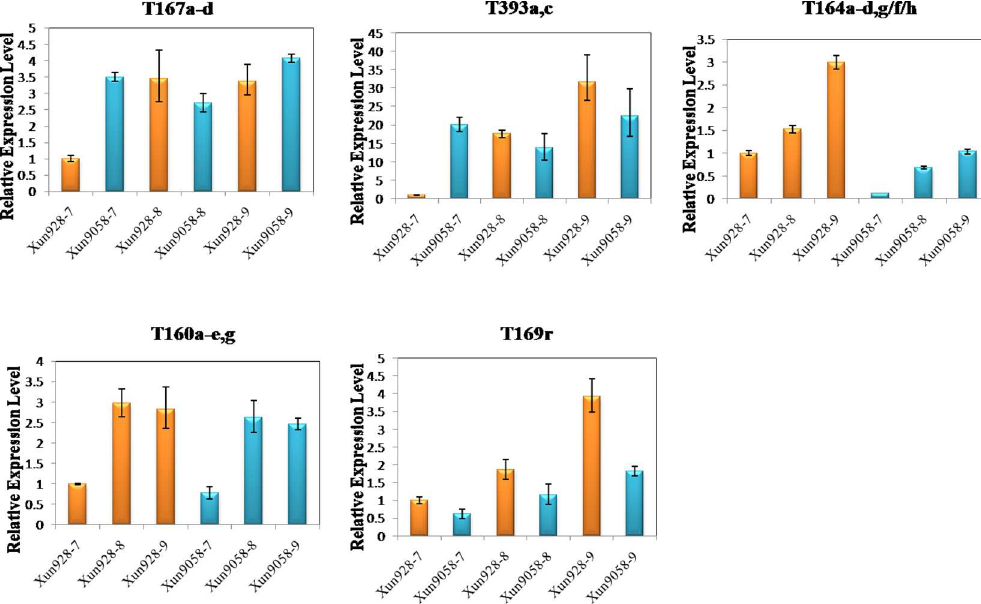
Fig 4. Expression levels of the maize internode-associated miRNA targets as determined by RT-PCR. 18S rRNA was used as the reference gene. Three biologicalreplicates and three technical replicateswere performed. T, target. Data represent the mean values ± SD of three